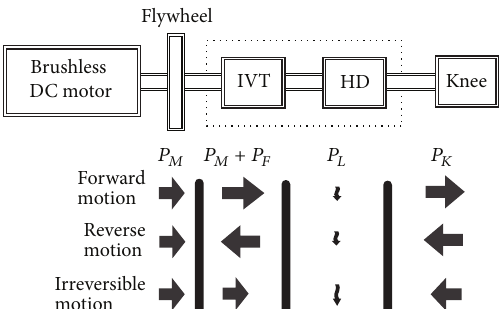
Figure 2: Fluxes of power in the F-IVT under forward, reverse, and irreversible motion conditions. The arrows indicate the power flows direction in each of them ( 𝑃 𝑀 motor power, 𝑃 𝐹 rate of change of the kinetic energy of the flywheel, 𝑃 𝐿 power losses in the transmission devices, and 𝑃 𝐾 knee